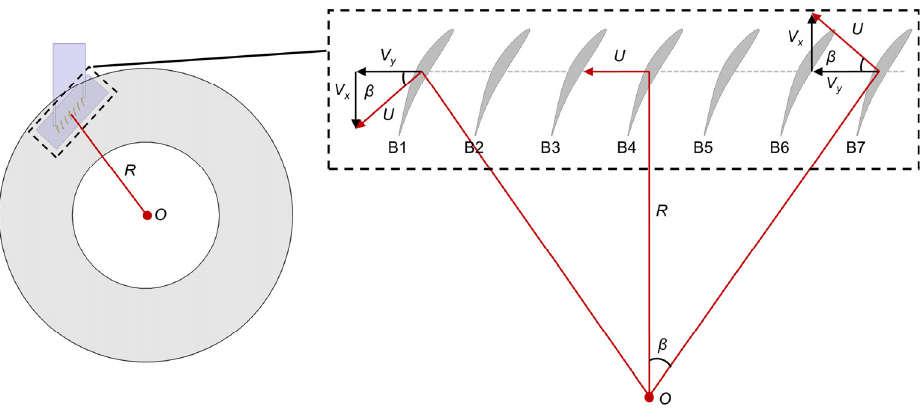
Figure 4. Schematic of axial velocity change with the pitch location.